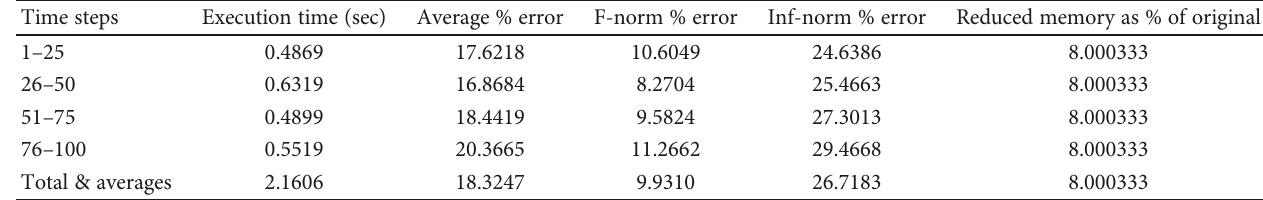
Table 17: 3D reduced model of velocity in the x direction over four sets of 25 time steps.